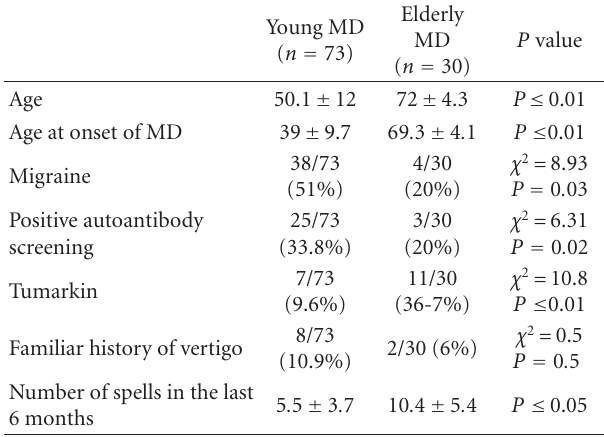
Table 1: Demographic and clinical data in elderly and younger MD